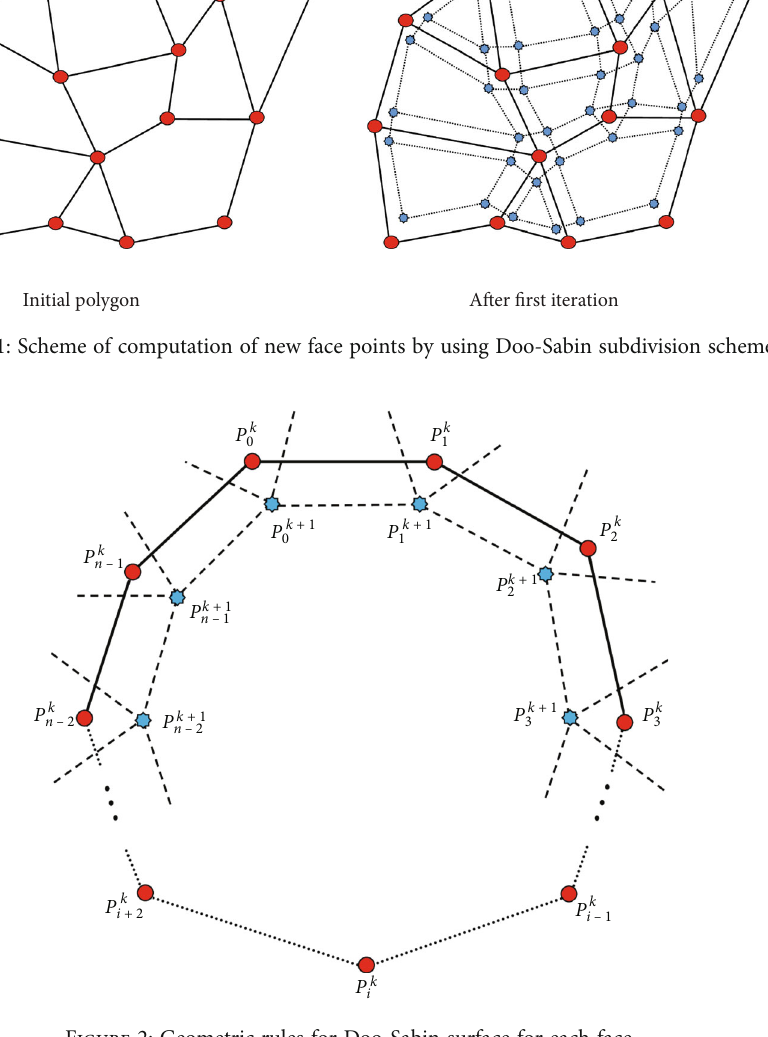
Figure 2: Geometric rules for Doo-Sabin surface for each face.